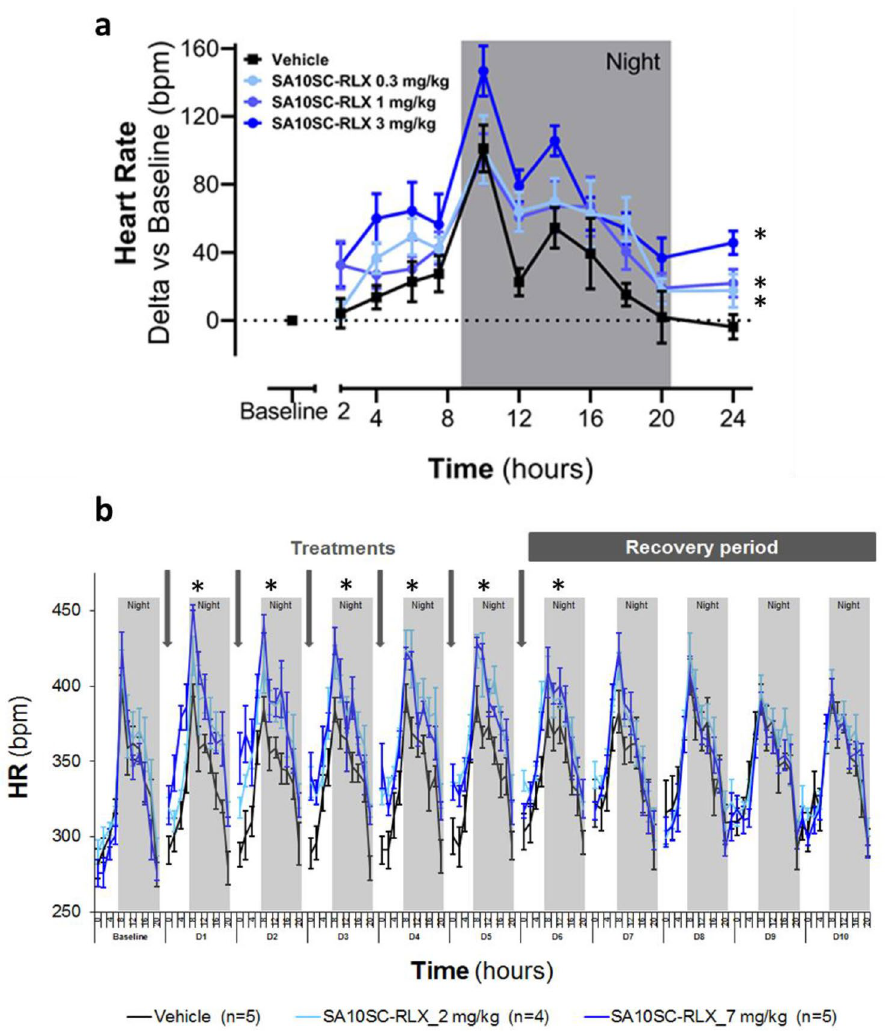
Figure 5. Effects of SA10SC-RLX in conscious healthy telemetered SD rats. Effects of a single SC administration of SA10SC-RLX at 3 doses (0.3, 1 and 3 mg/kg) on heart rate (HR) (changes from baseline) ( a ). Results are expressed as mean ± SEM (n = 8 animals/group). Whatever the dose considered, 0.3, 1 or 3 mg/ kg, the mean effect of SA10SC-RLX is significantly different from the mean effect of the vehicle (p = 0.0001 at 0.3 mg/kg, p = 0.0032 at 1 mg/kg, p = 0.0002 at 3 mg/kg). Effect of repeated SC administrations of SA10SC-RLX at 2 doses (2 and 7 mg/kg) on HR (raw data, beat per minute (bpm)) ( b ). The arrows indicate the administration of the compound or the vehicle. Results are expressed as mean ± SEM (n = 5 animals/group) and are presented for each day (D1–D10 after baseline (24 h) recording for each animal). A two-way analysis of variance was performed on the raw data with fixed factors group and time, and if the group factor or the interaction group x time were significant, a global Dunnett’s test was carried out to compare the global effects of the treated groups to the global effect of the vehicle group (* P <